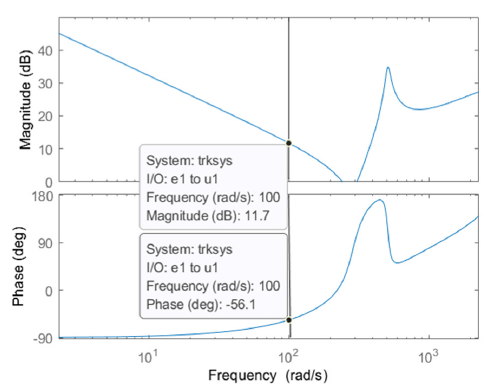
Figure 13. Bode diagram of LQG Controller.